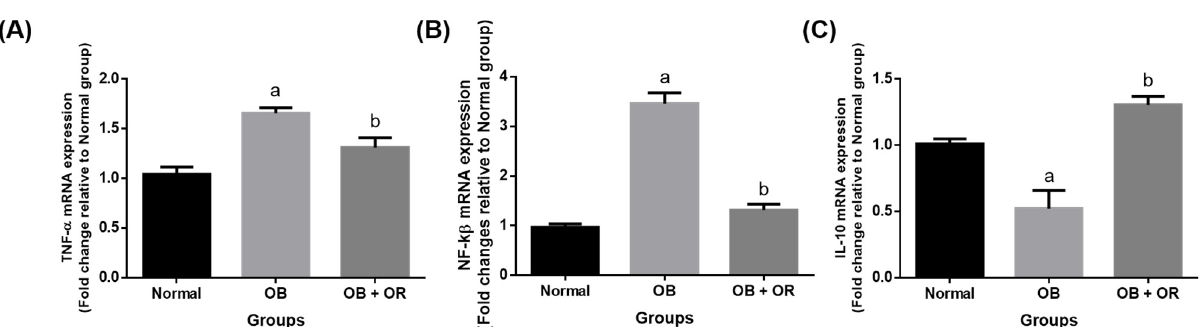
Figure 2. Cardiac mRNA expressions of ( A ) TNF- α , ( B ) NF- ĸβ , and ( C ) IL-10 in Normal, OB (Obese control), and OB + OR (obese and orlistat 10 mg/kg/day) groups. Values are presented in mean and SEM, n = 6 rats per group. a p < 0.05 compared with Normal group, b p < 0.05 compared with OB group. Data were analyzed by One-way ANOVA followed by Tukey’s post-hoc test. TNF- α ; tumour necrosis factor- α , NF- ĸβ ; NF- κβ : nuclear factor kappa β , IL; interleukin.